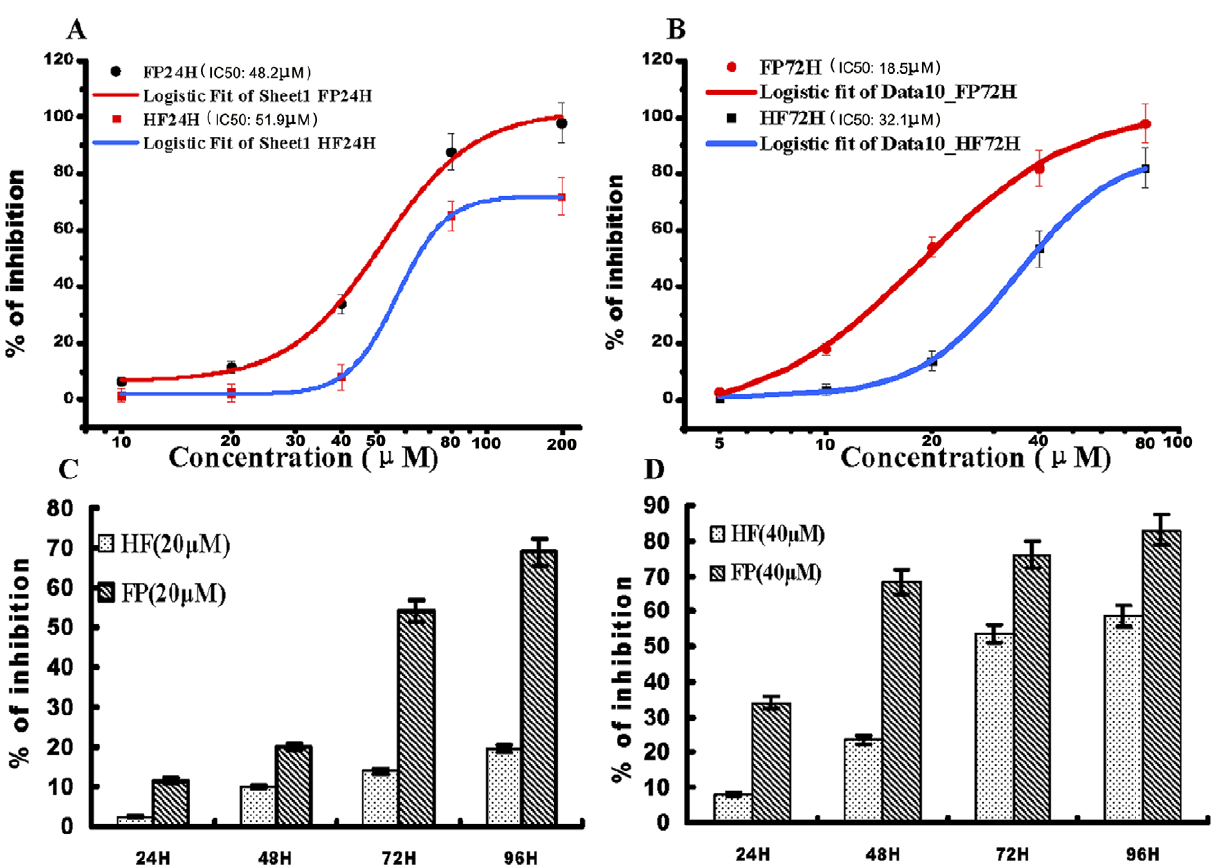
Figure 1. Effects of test compounds on cell growth inhibition. A) Effects of test compounds at different concentrations on HeLa cells following treatment for 24 h. IC 50 values for FP and HF at 24 h were 46.8 and 56.9 m M, respectively. B) Effects of test compounds at different concentrations on HeLa cells following treatment for 72 h. IC 50 values for FP and HF at 72 h were 18.5 and 32.1 m M, respectively. C) Effects of 20 m M HF and FP on cell viability following treatment for 24, 48, 72 and 96 h. D) Effects of 40 m M HF and FP on cell viability following treatment for 24, 48, 72 and 96 h. All data points represent mean 6 SEM values.